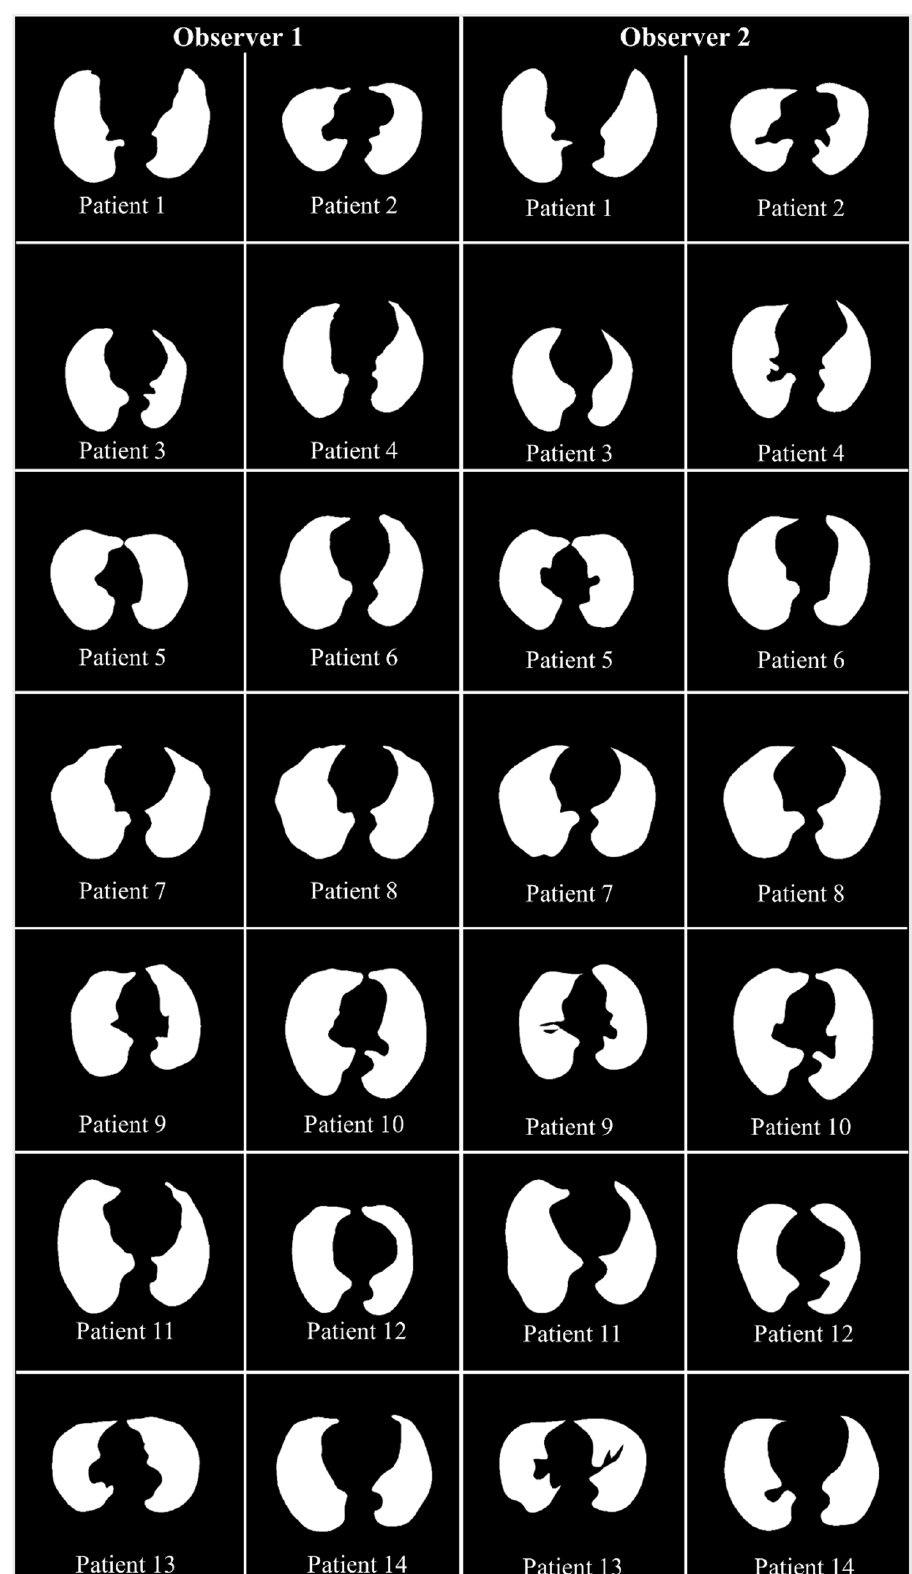
Figure 3. GT white binary mask for AI model training for Observer 1 vs. Observer 2.